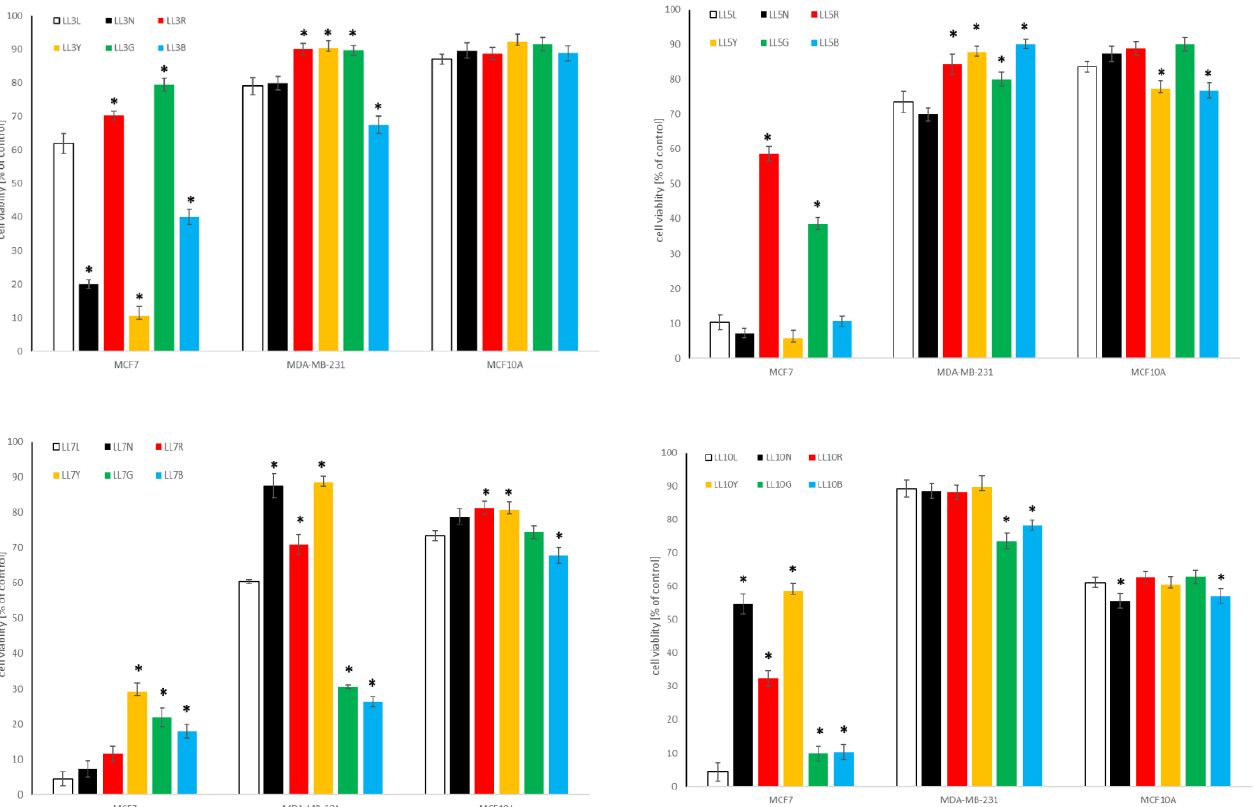
Figure 4. Cytotoxic effect of the extracts of lupin sprouts (LL) harvested for 3, 5, 7, and 10 days in different LED light conditions: natural (L), darkness (N), red (R), yellow (Y), green (G), blue (B) on breast normal (MCF10A) and cancer (MCF7, MDA-MB-231) cells. Cells were treated with 500 µg/mL of sprout extracts (n = 3) for 24 h. Values are presented as the mean ± SD (standard deviation). Significant differences ( p < 0.05) for each cell line refer to normal sprouts harvesting procedure and are marked as *.